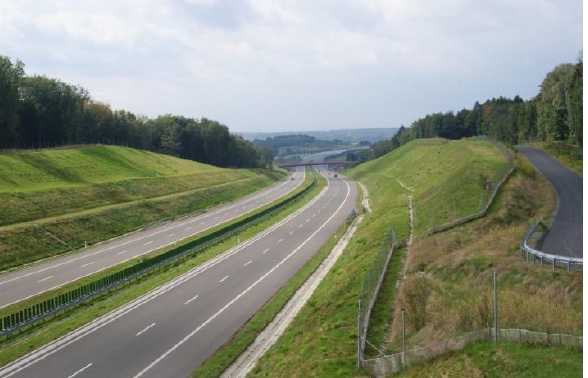
Fig. 2. The A1 motorway at the border of the communities Godów and Mszana – photo made the north of the bridge on 1 Maja Street in Mszana ( T. Dulias )